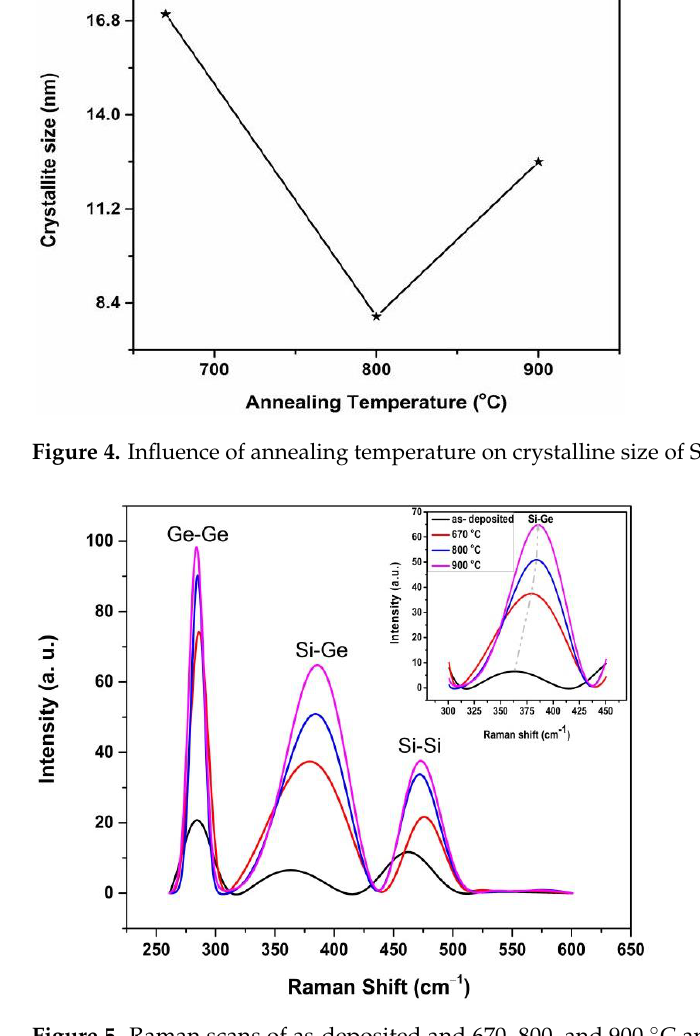
Figure 5. Raman scans of as-deposited and 670, 800, and 900 °C annealed SiGe/quartz thin films. The inset displays shift in Si-Ge peak with annealing temperature.